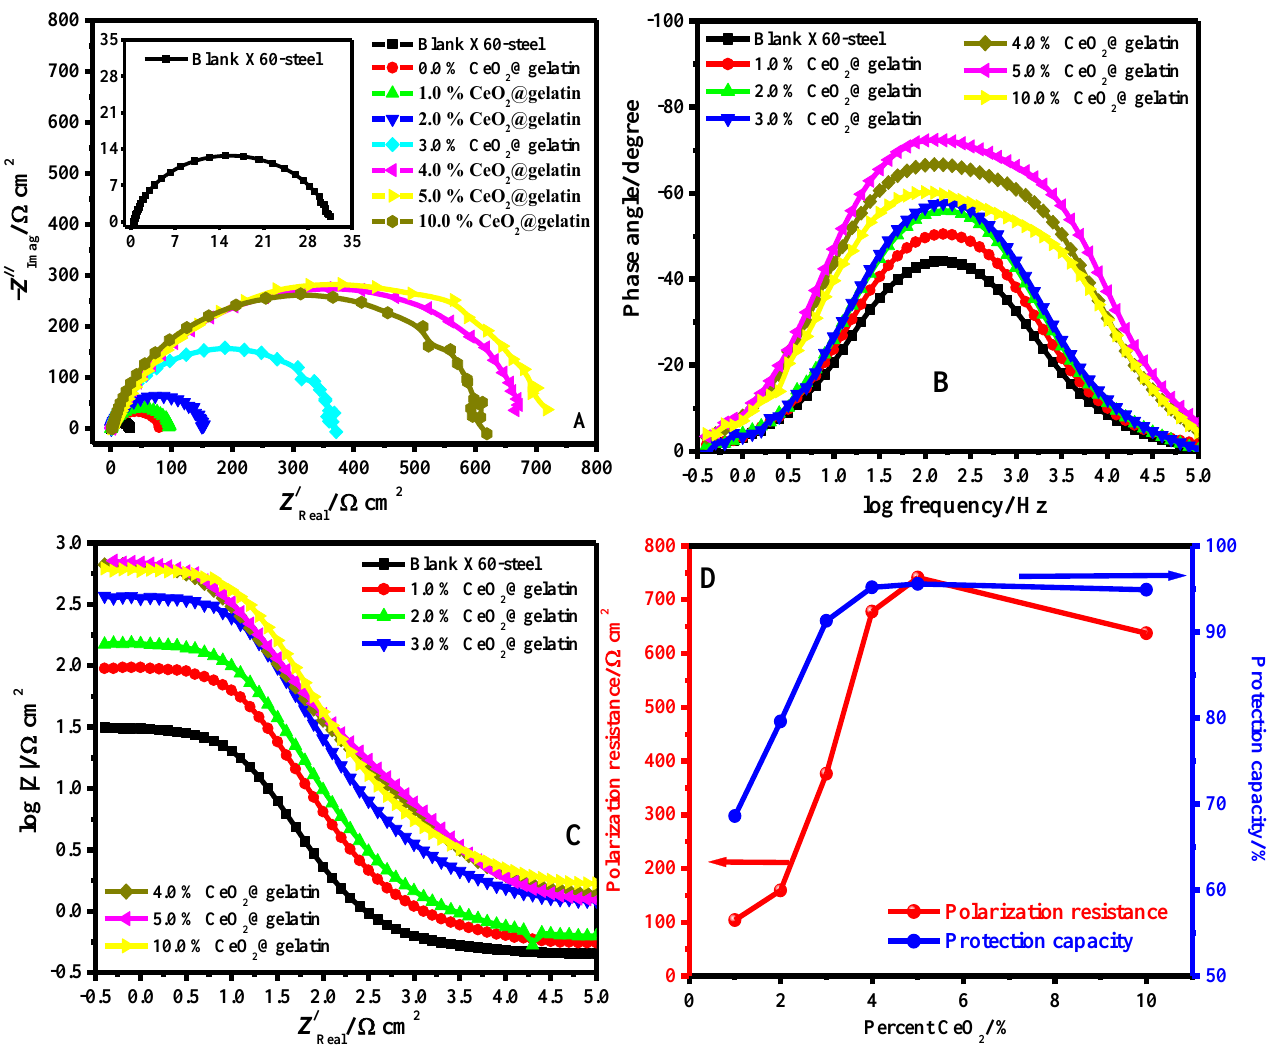
Figure 7. ( A ) Nyquist, ( B ) Bode, ( C ) Bode phase plots in 15% HCl solution for blank X60-steel and coated samples with different percent of % CeO 2 @gelatin at 50 °C and ( D ) Effect of CeO 2 percent on the polarization resistance and protection capacity.